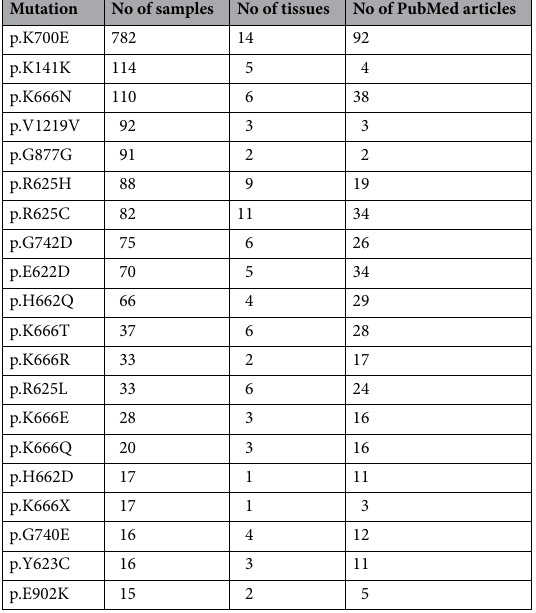
Table 3. The top 20 frequent mutations of SF3B1 that were detected in tumor samples.